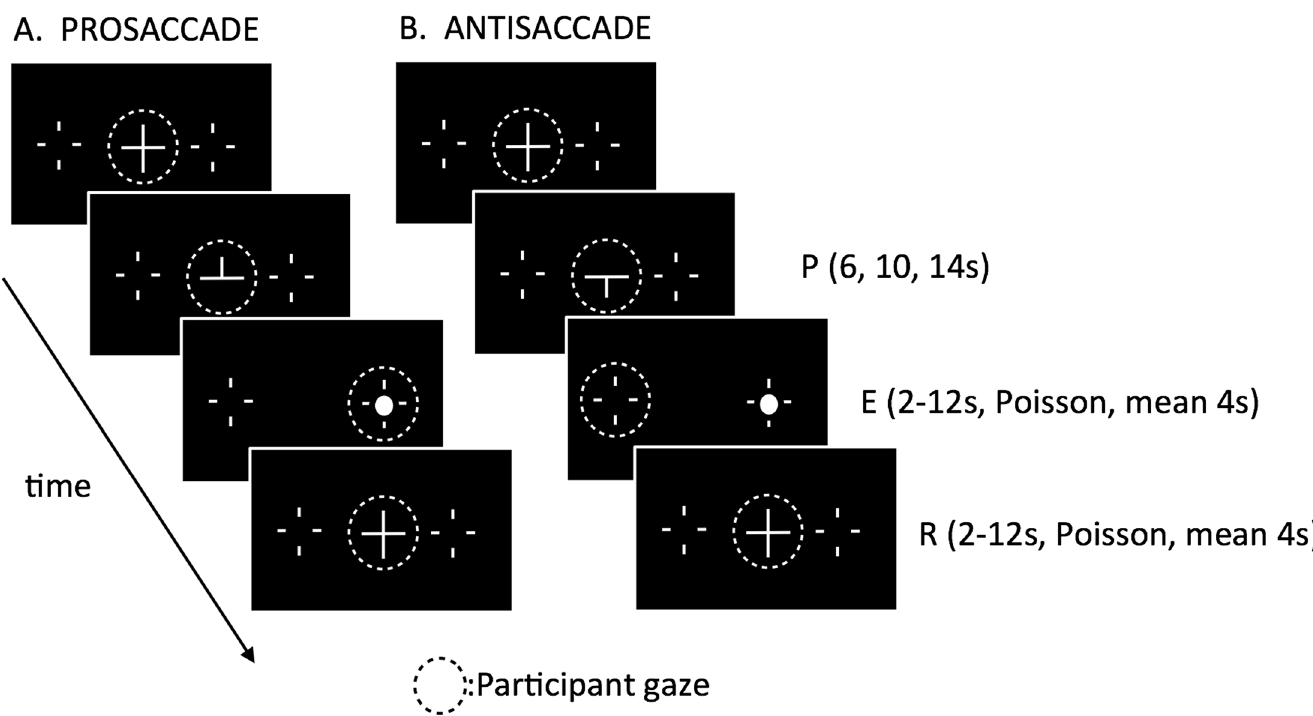
Fig 1. Diagram illustrating the two conditions used in the experiment. A: Pro-saccade trial. B Anti-saccade trial. The dotted circle indicates eye position at any given time and was not present on the screen. The panels show the successive events described in the text. Key: P = preparation, E = execution, R =